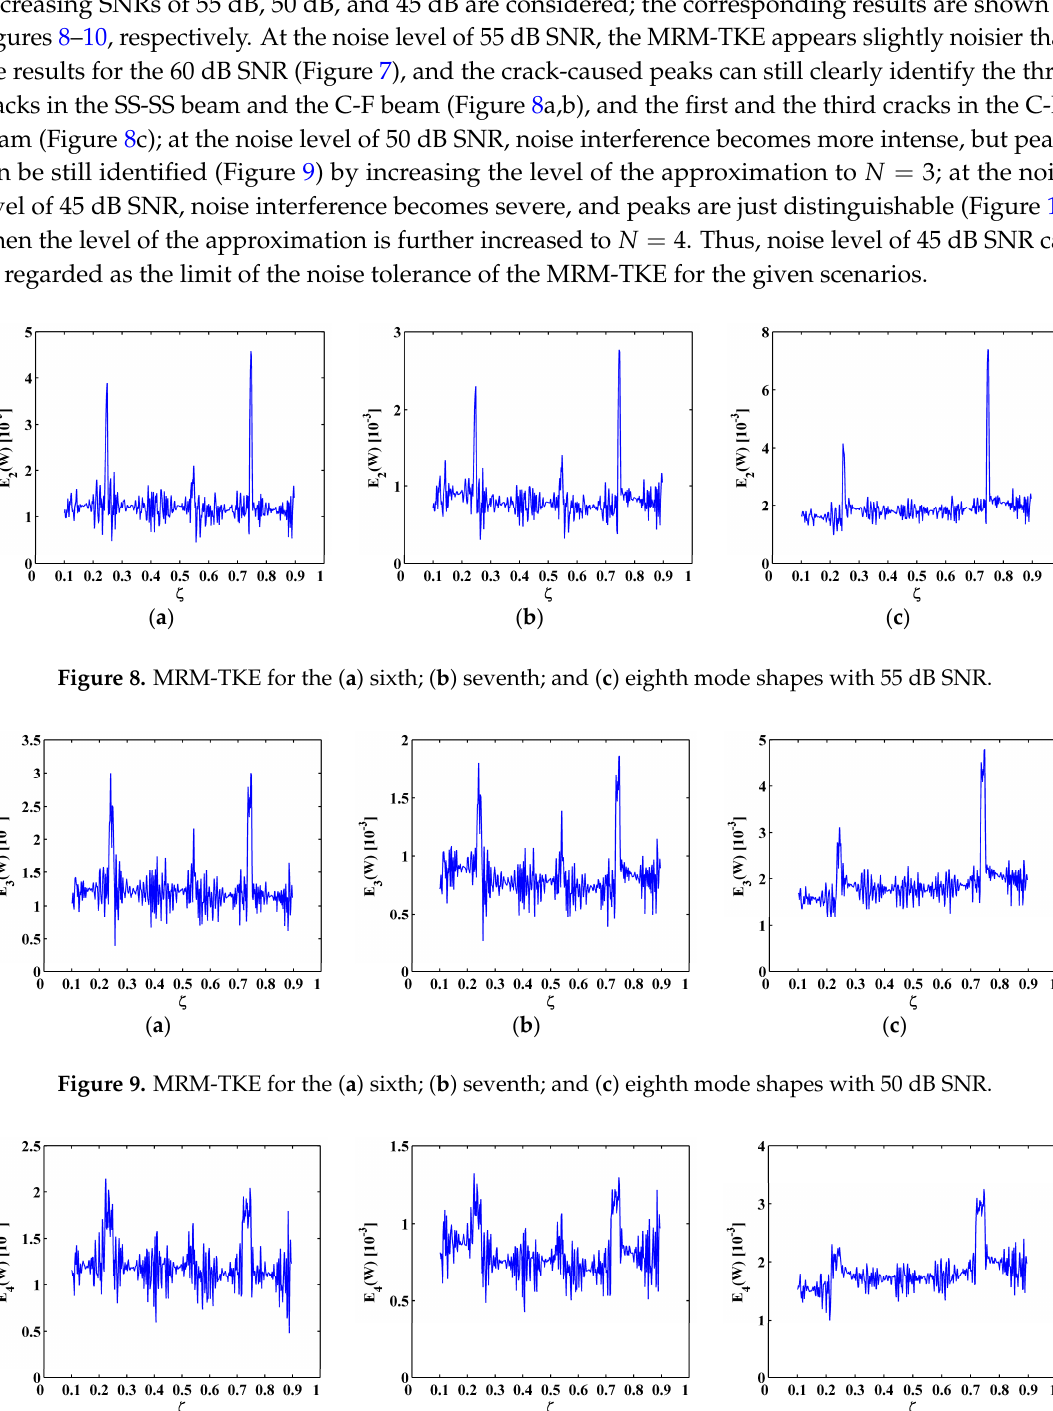
Figure 7. MRM-TKE for the ( a ) sixth; ( b ) seventh; and ( c ) eighth mode shapes with 60 dB SNR.